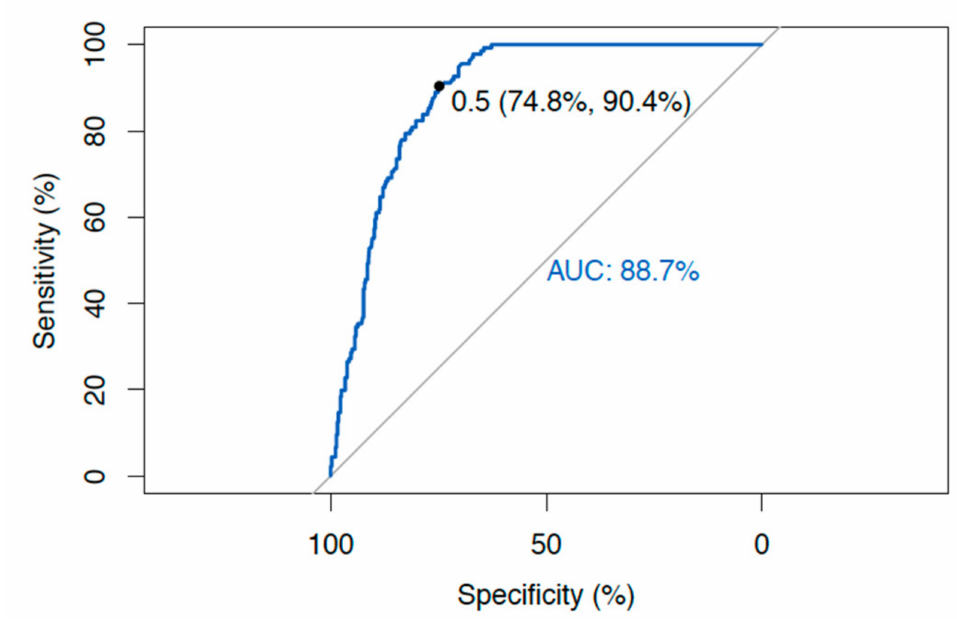
Figure 3. ROC curve analysis of Hsp65 as a diagnostic test with sensitivity and